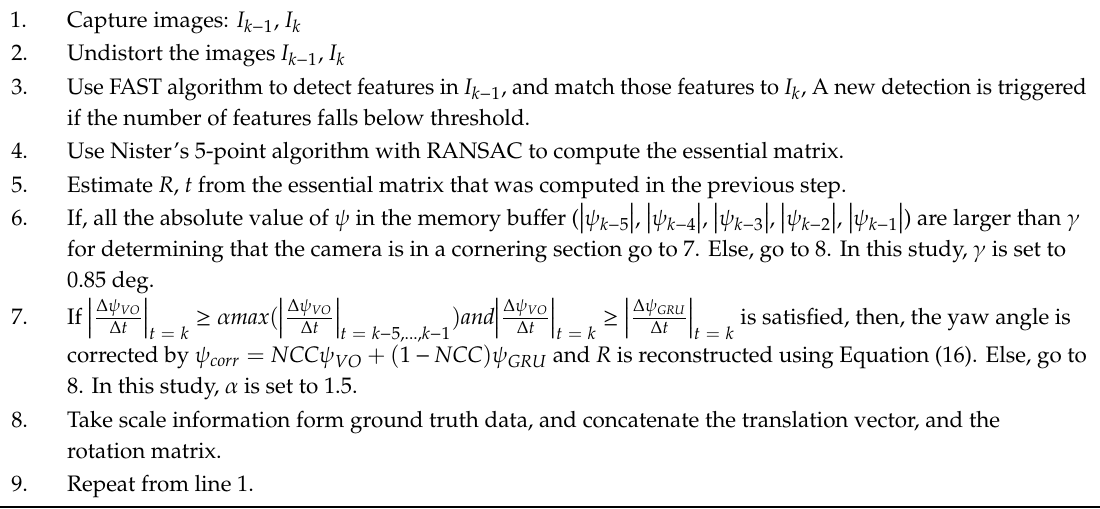
Algorithm 2 Pseudo-code of Monocular Visual Odometry algorithm based on proposed method. 2D-to-2D Monocular Visual Odometry with Pose Correction Using a GRU